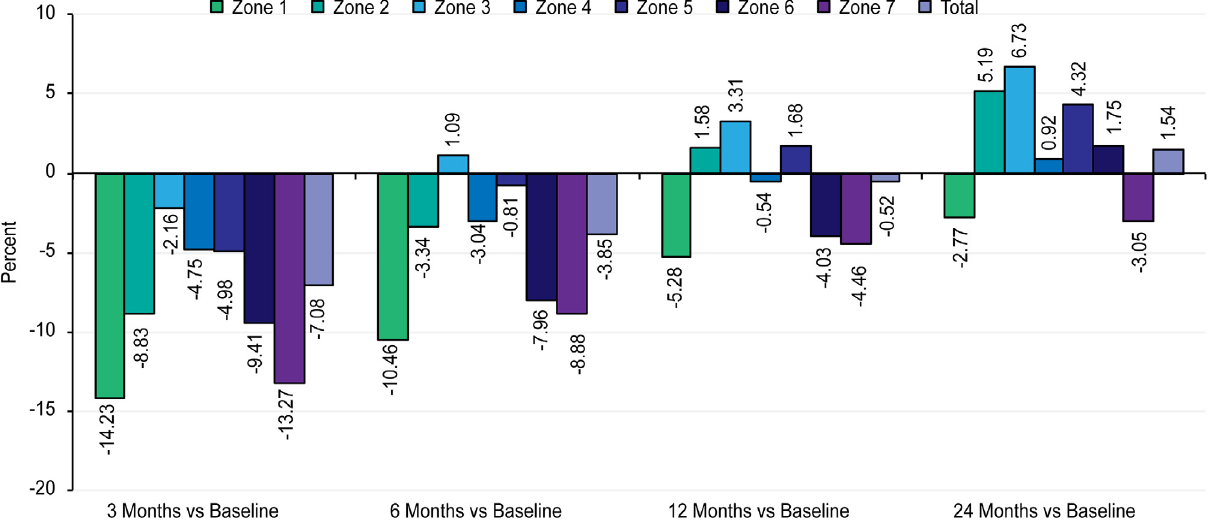
Figure 2. Bar chart showing the DEXA results 3, 6, 12, and 24 months as compared with baseline.